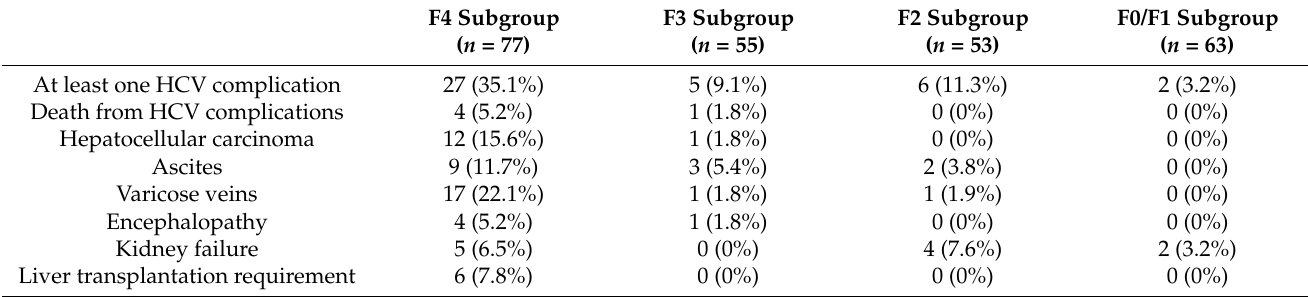
Table 3. Quantitative description of each complication developed according to the baseline fibrotic stage.